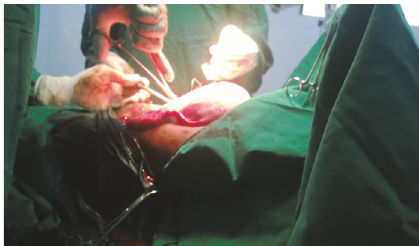
Figure 1: Distended abdomen due to haematometra appears likely to be a full-term pregnancy woman.